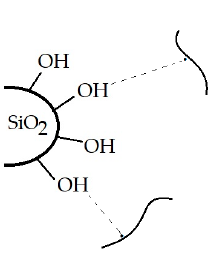
Figure 4. The illustration of the basic interaction between silica particles and free radicals.